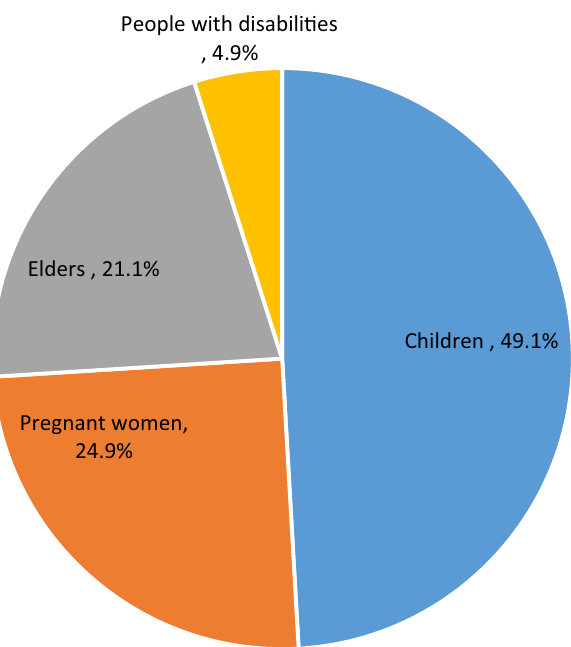
Figure 2. Distribution of enteric infections among vulnerable groups of the community in a rural northwest Ethiopia, May 2016 (note: elders were family members aged above 64